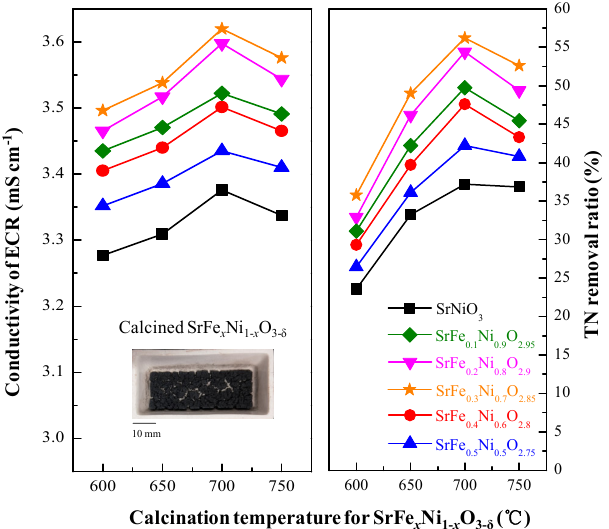
Figure 5. The effect of calcination temperature on the electrocatalytic properties of SrFe x Ni 1− x O 3−δ.